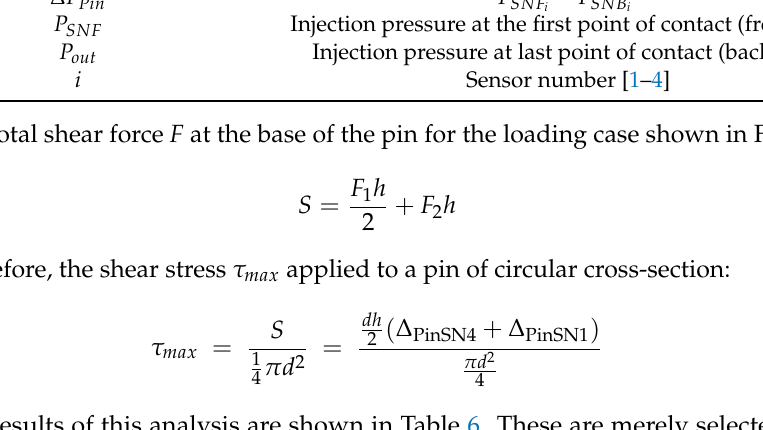
Table 5. Description of variables in shear stress formula. Symbol Parameter τ max